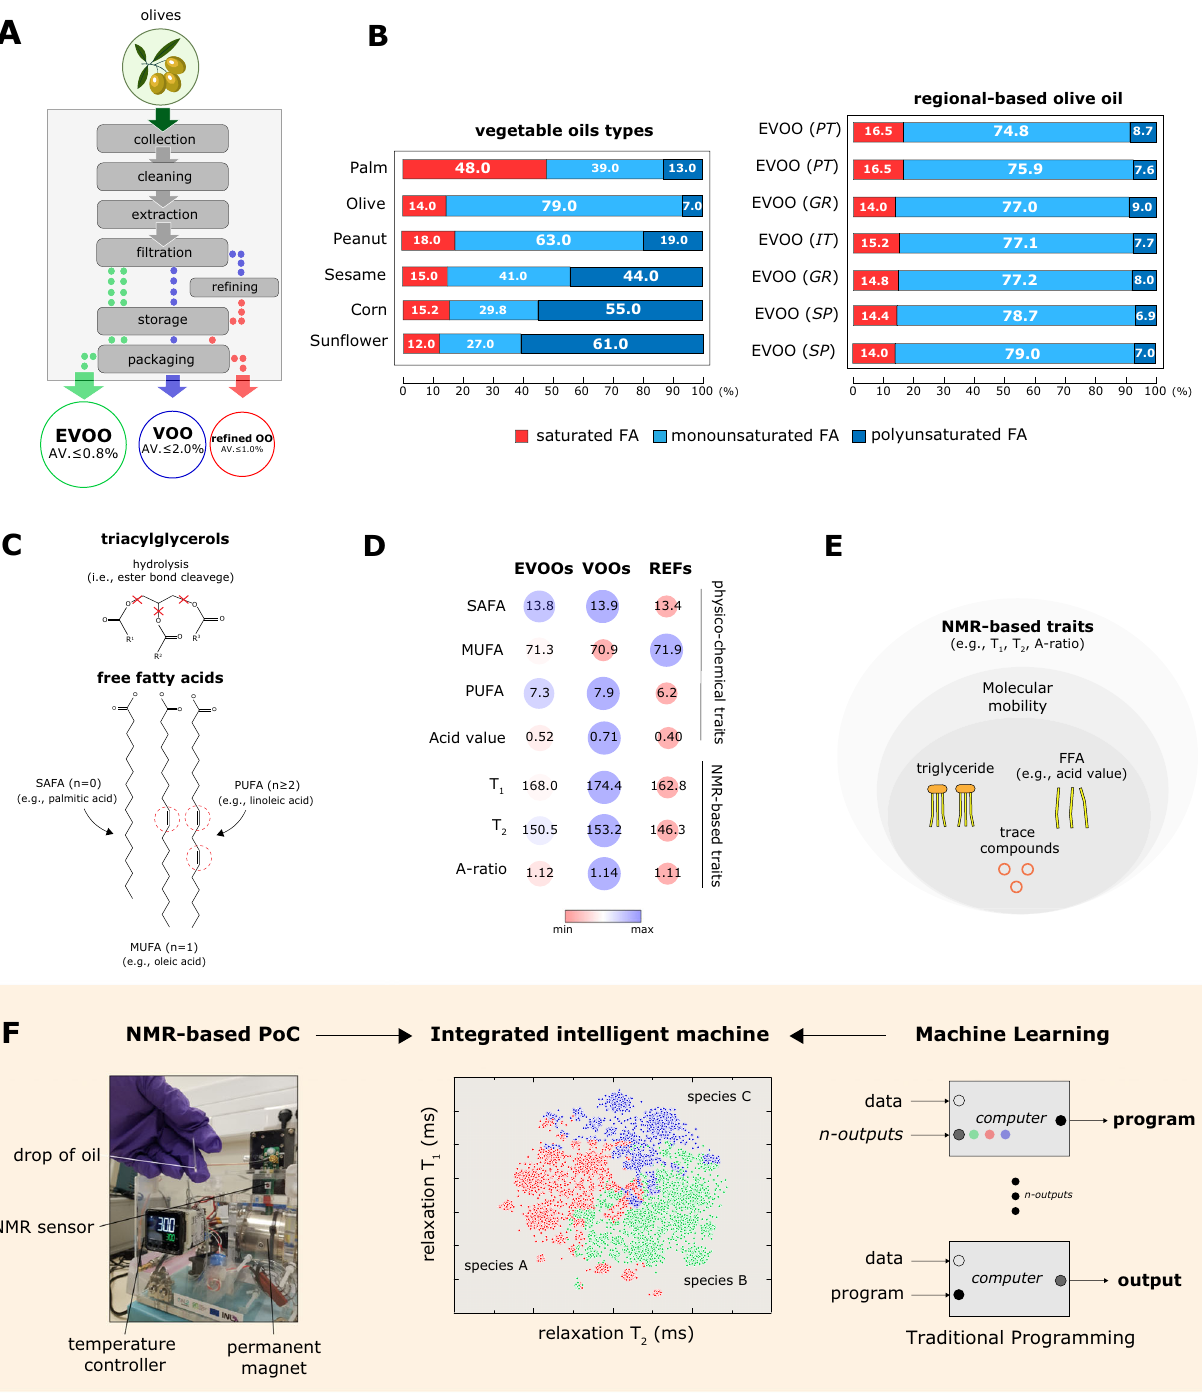
combining the (old-fashioned) machine with the (new-wave) of machine learning, to produce an ′ intelligent machine ′ 30,36,37 , an attractive scienti fi c solution for the food science community. In order to demonstrate the industrial applications, we use the proposed technique to validate the authenticity of EVOO from